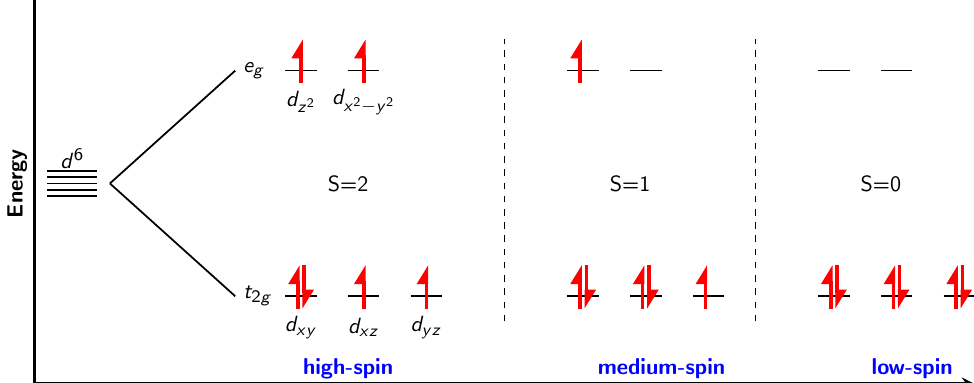
Figure 3. Splitting of d orbitals in the perfect octahedral ligand field, with possible electron configu- rations for d 6 Ni 4+